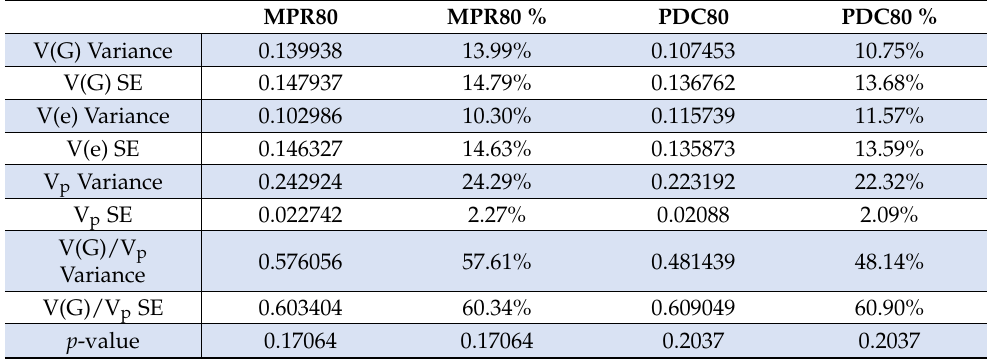
Abbreviations: Chr = chromosome, OR = odds ratio, AA = amino